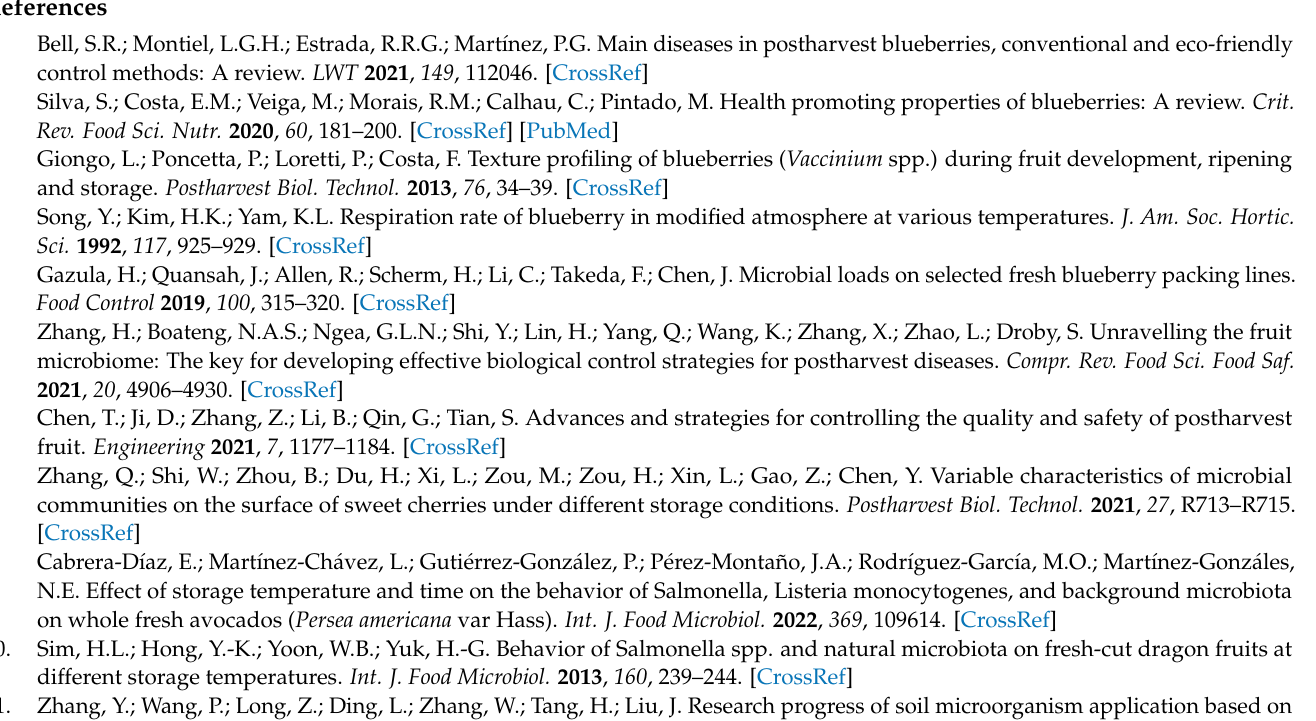
Figure S1: Scatter diagram of the ratio differences between the 16S and ITS Shannon and Simpson diversity indexes; Figure S2: a and b represent the box plots of the α -diversity index of the bacterial and fungal microbial communities (Shannon and Simpson index intra- and inter-group validation). c and d represent the scatterplot of the distances between two pairs of ITS and 16S sequencing data